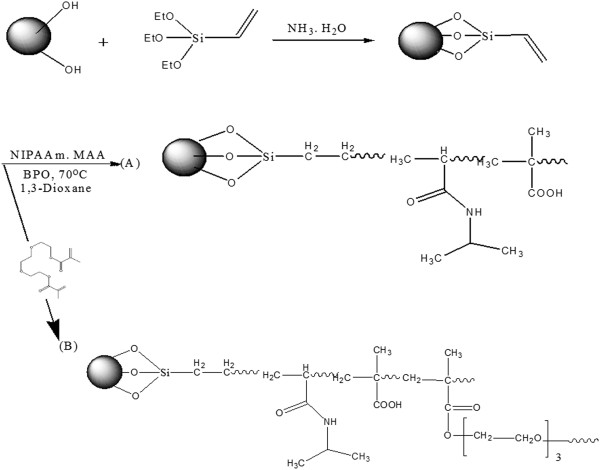
(A) Chemical modification of Fe3O4 surface by grafting polymerization without cross-linking (B) In presence of cross-linking.